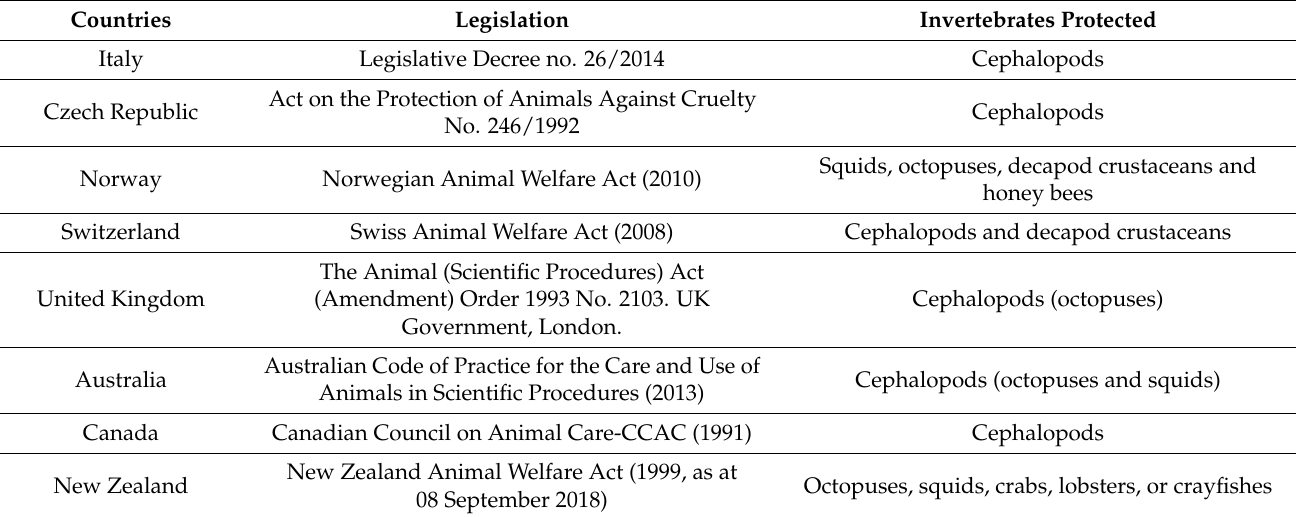
Table 2. List of legislation and codes of practice relevant to invertebrates used in the scientific research in different countries inside and outside